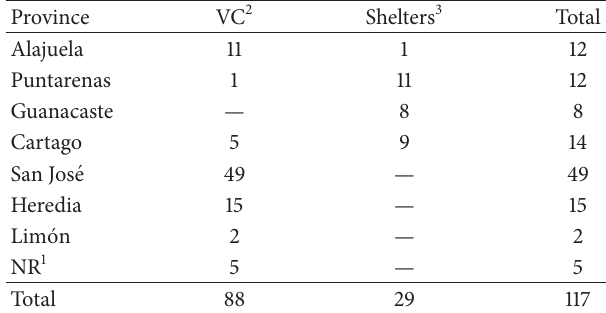
Table 1: Distribution of analyzed psittacines by